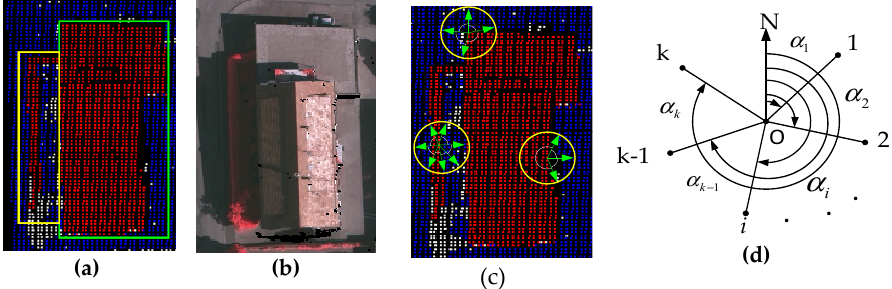
Figure 5. Concept of intersection angle. ( a ) Building extraction after restricted region growing; ( b ) Orthophoto; ( c ) Concept of intersection angles; ( d ) Calculation of the maximum intersection angle.